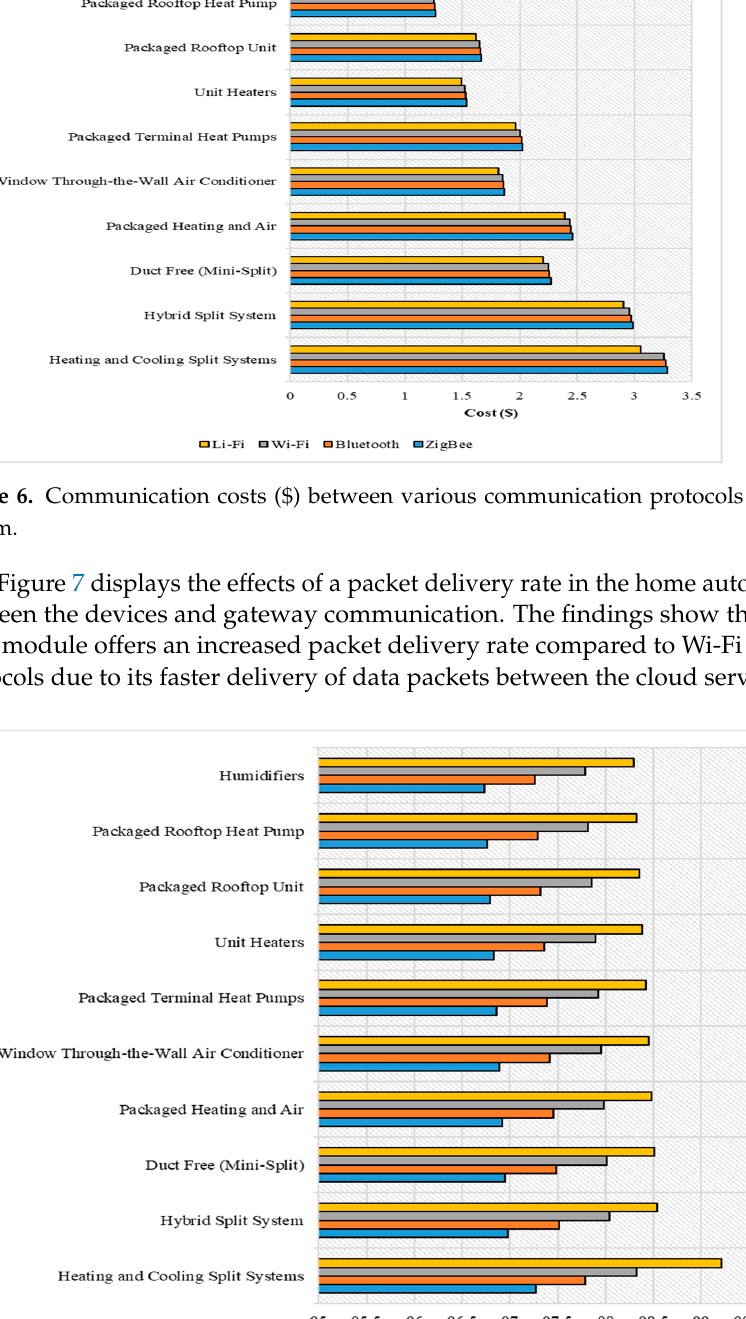
Figure 5. Computational times (s) between various communication protocols using the CRNN system.